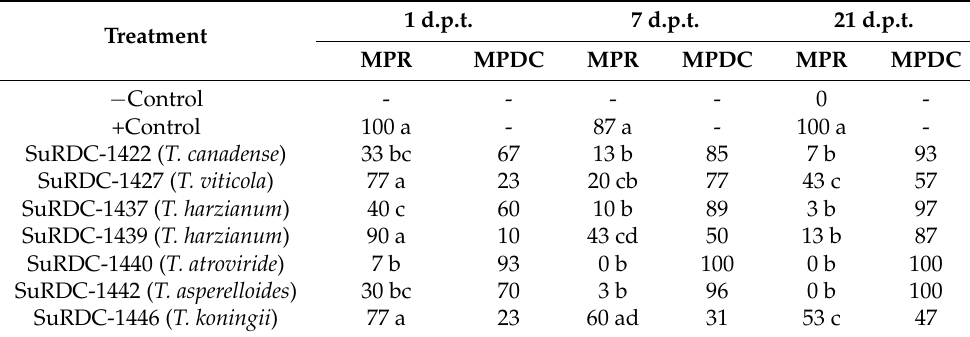
Table 3. Efficacy of Trichoderma isolates from BC applied immediately after pruning, followed by inoculation of 5000 conidia of D. seriata 1 day, 7 days, and 21 days post-treatment in a detached cane assay experiment.